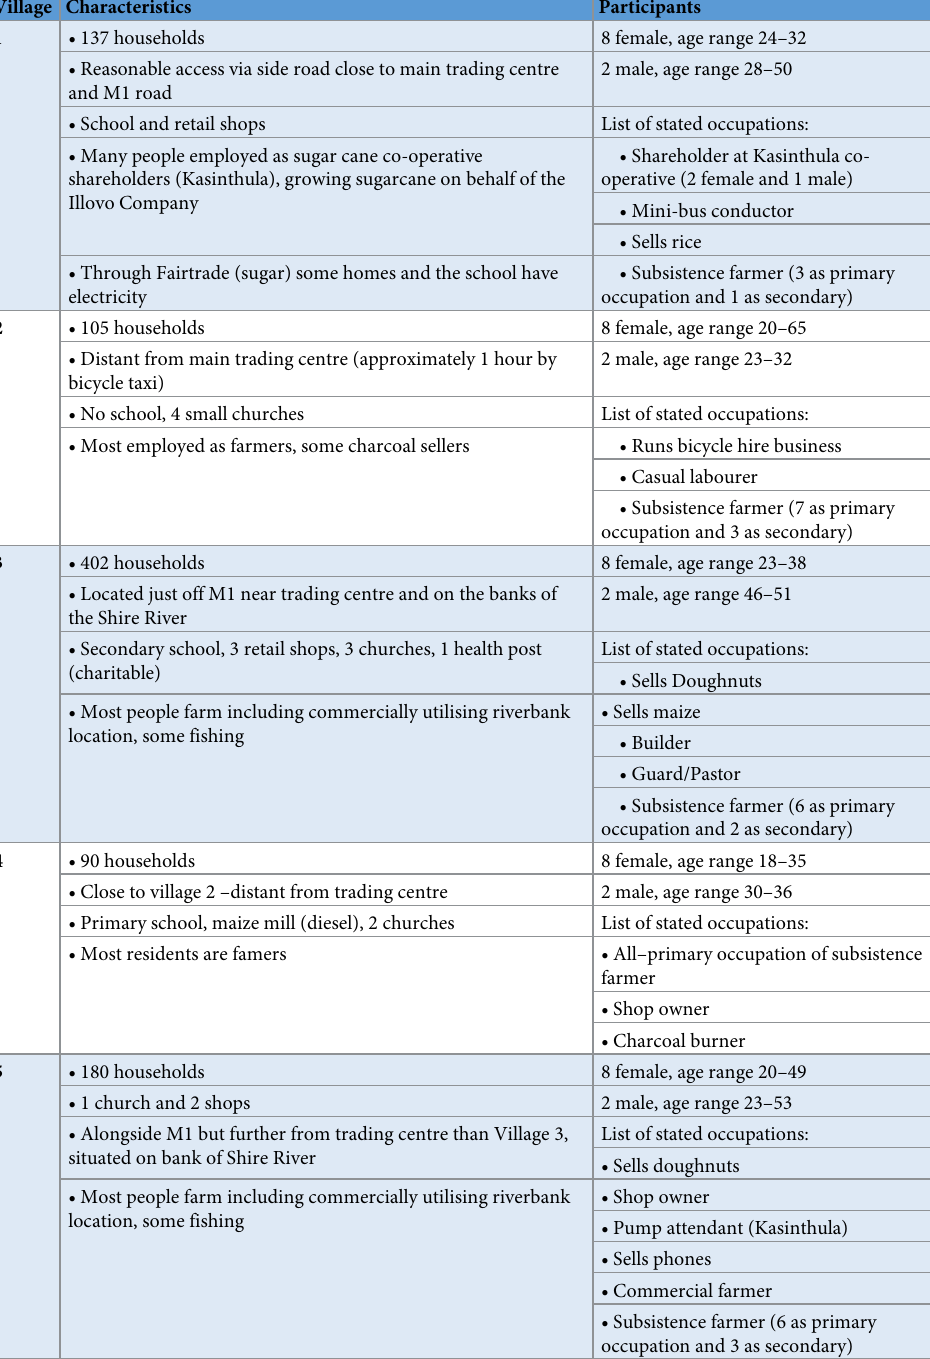
Table 2. Village characteristics and details of Photovoice